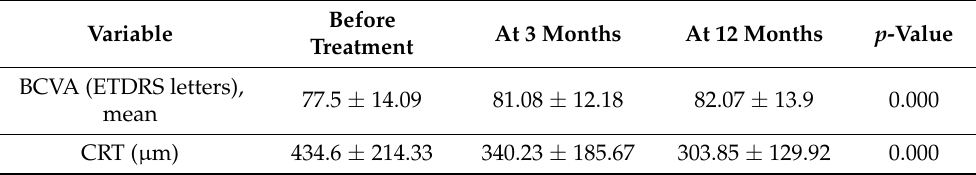
Table 2. Effects of anti-VEGF treatment at 12